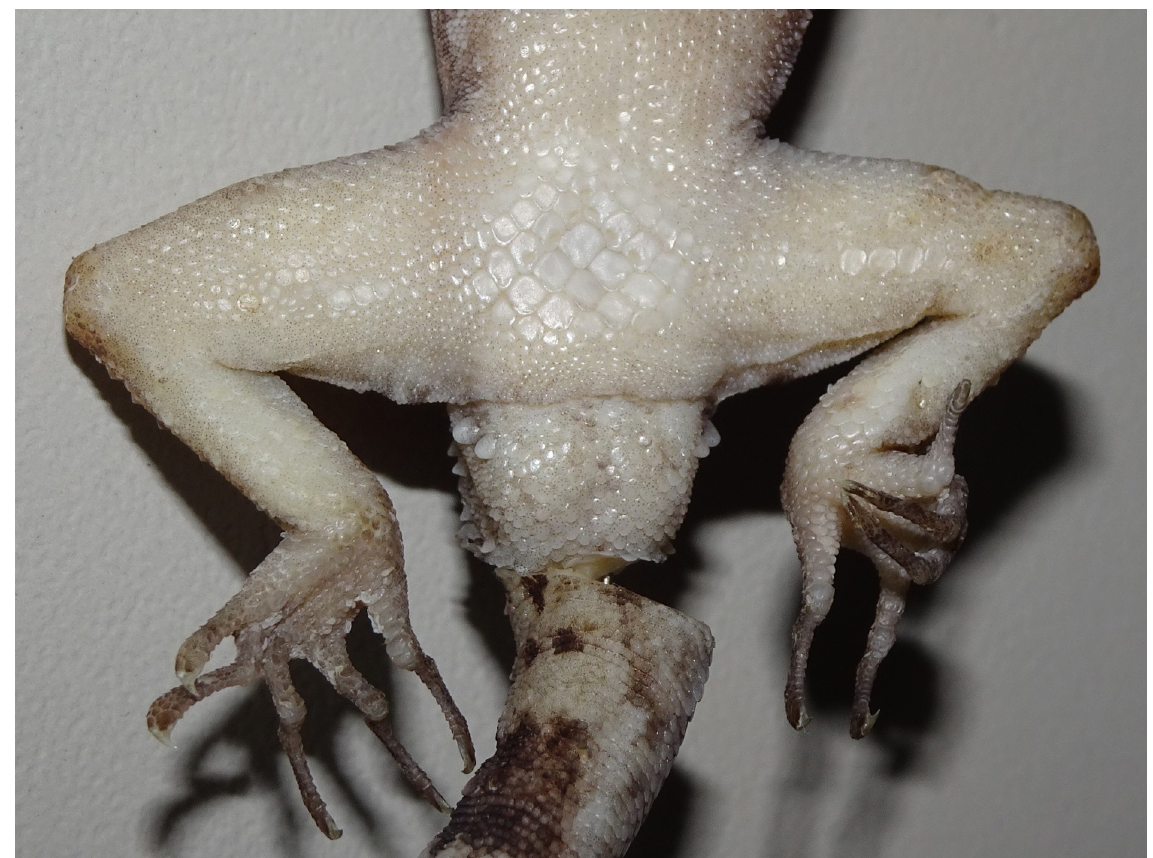
Fig. 6. Cyrtodactylus chungi sp. nov., holotype, ♂ (IEBR 4581). Cloacal region in preservative. Photo T.